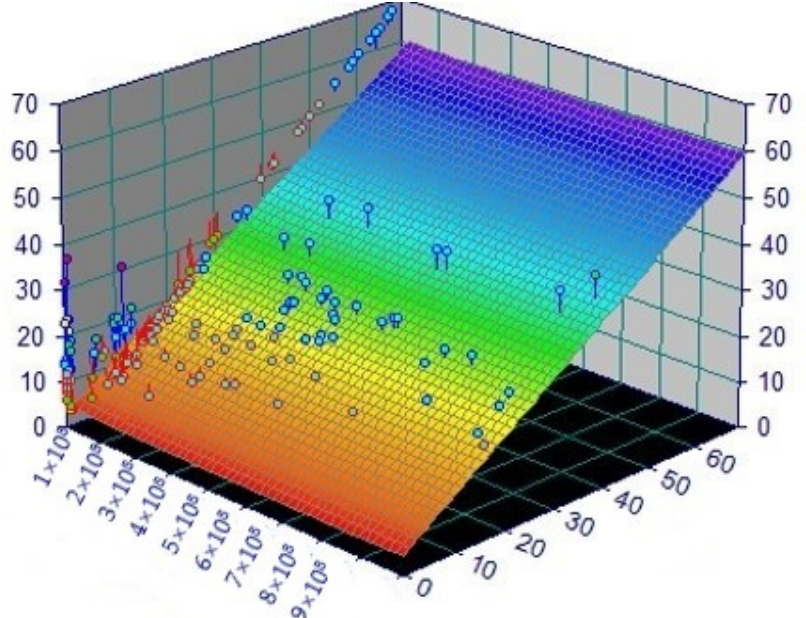
Figure 20. When the Reynolds number is substituted into the calculation formula, the correlation between the calculated value and the experimental value is as shown (XYZ axis represents v sg , Reynolds number and pressure drop (kPa), respectively).